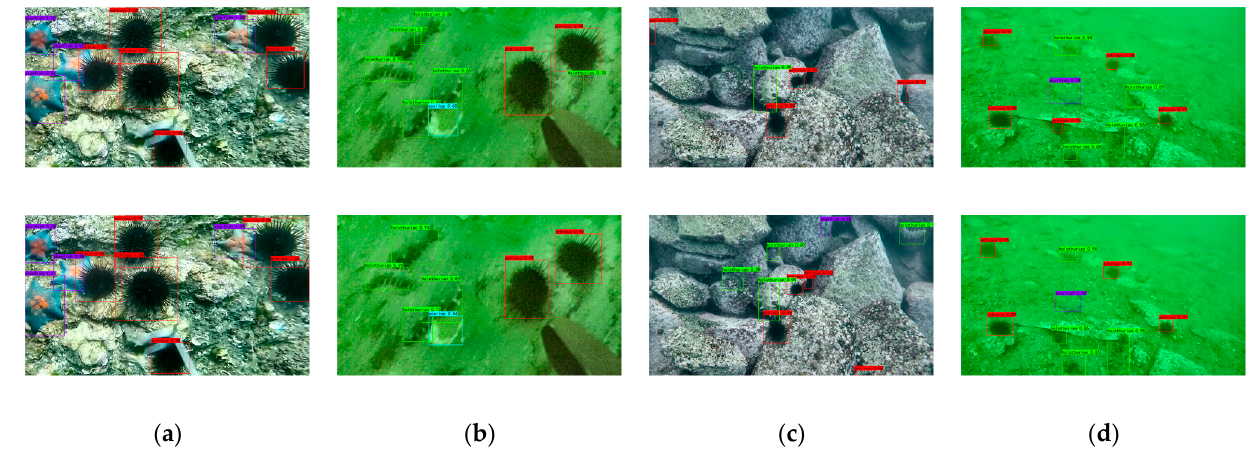
Figure 14. Visualization detection results of different algorithms in the four scenes: ( a ) close-range clear; ( b ) close-range blur; ( c ) long-range clear; ( d ) long-range blur. From the first row to the fifth row: Faster R-CNN’s result; Faster R-CNN-FPN’s result; SSD’s result; Mobile-SSD’s result; YOLOv4 ′ s result; CenterNet’s result; RetinaNet’s result; EfficientDet’s result; EDR’s result.